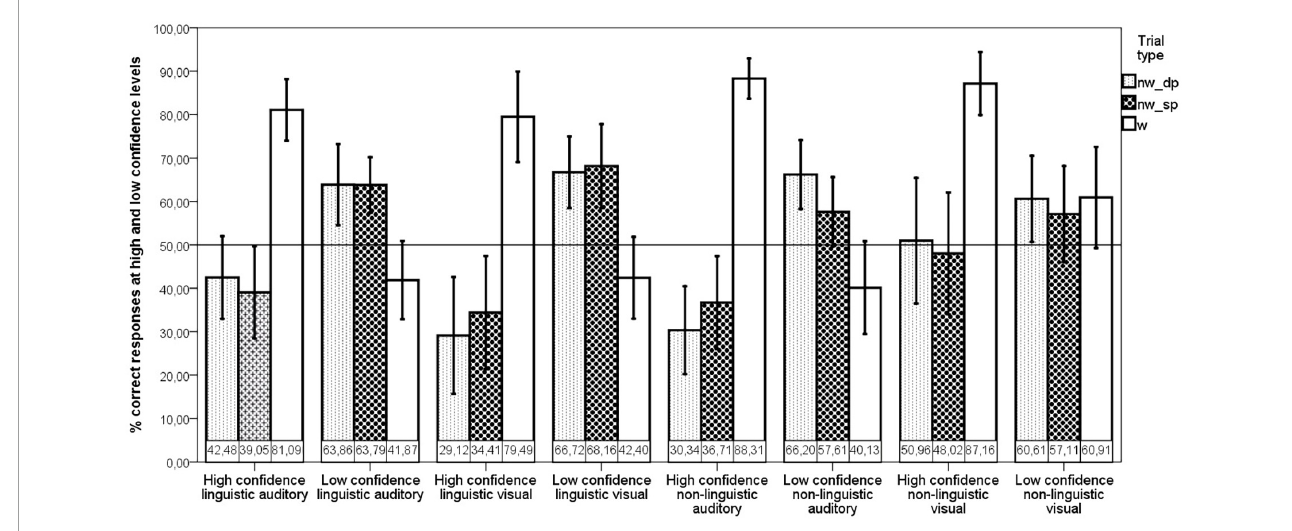
FIGURE1 Meta-sensitivity measured as the percentage of correct responses for high and low confidence levels. If a participant gave only 5 responses with high confidence but all 5 responses were correct (100%), his metacognitive sensitivity was considered to be higher than that of a participant who gave 20 responses with high confidence, with only 10 correct (50%). Meta-sensitivity was calculated separately in the visual and auditory modalities, linguistic and non-linguistic domains, and on three different token types: random foils (nw_dp), ordered foils (nw_sp) and triplets (w). The horizontal line represents performance at the chance